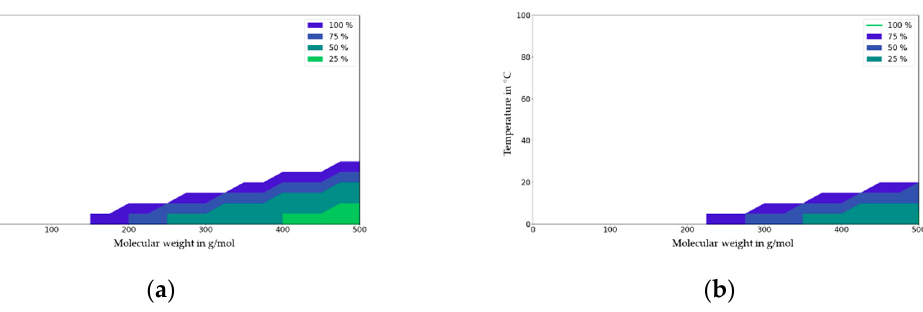
Figure 11. Migration map for PP for contact times of 6 h ( a ) and 1 day ( b ). Molecular weight in g/mol against temperature (T) in °C. Deviation of migration in mg/dm 2 independent of partition coefficient (K P,F ) expressed in % at a given initial concentration (1000 mg/kg), material thickness (2000 µm), and area to volume ration (6 dm 2 per kg food).